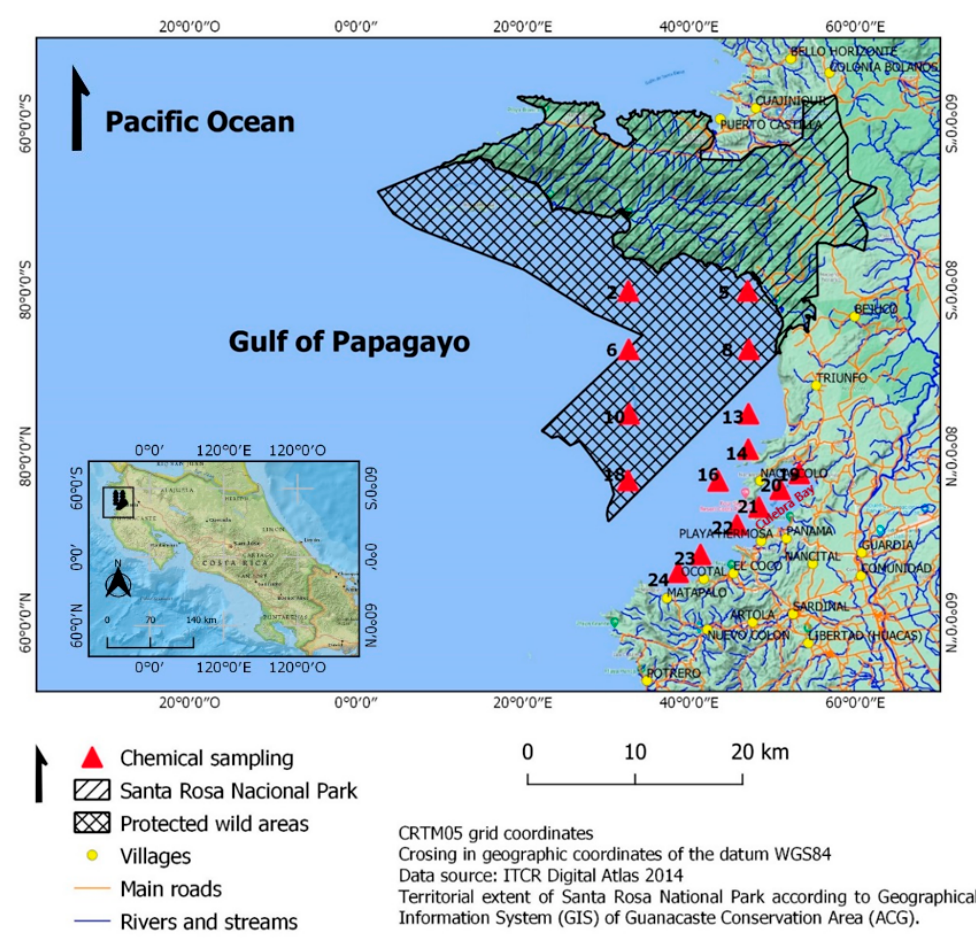
Figure 1. Location of sampling stations in the study